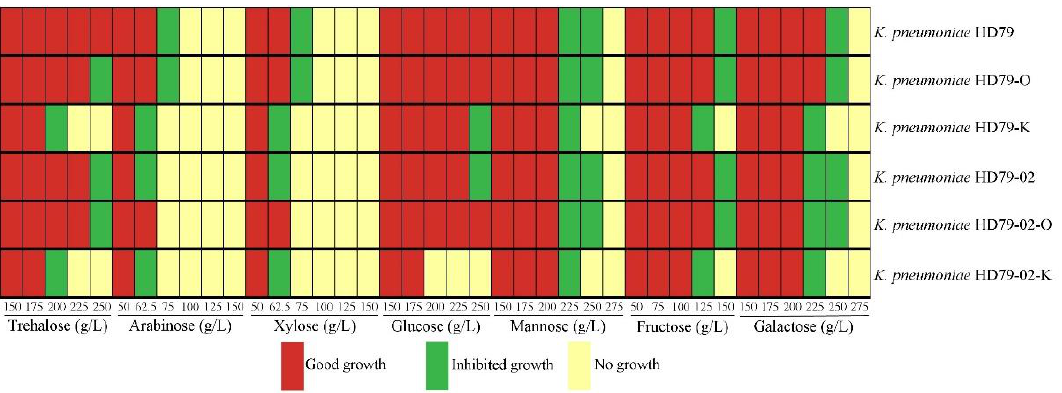
Figure 3. The growth of each strain on SFM plates containing different sugars and different concentrations. From left to right are trehalose, arabinose, xylose, glucose, mannose, fructose, and galactose. Red rectangles indicate good growth, green rectangles indicate inhibited growth, and yellow rectangles indicate no growth.